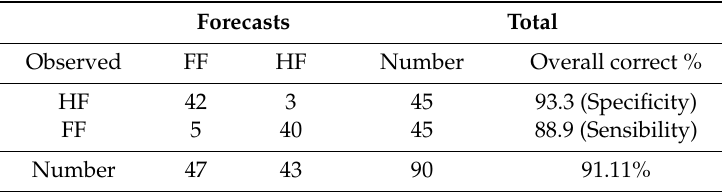
Table 5. Classification of failing firms (FF) and healthy firms (HF) three years earlier.